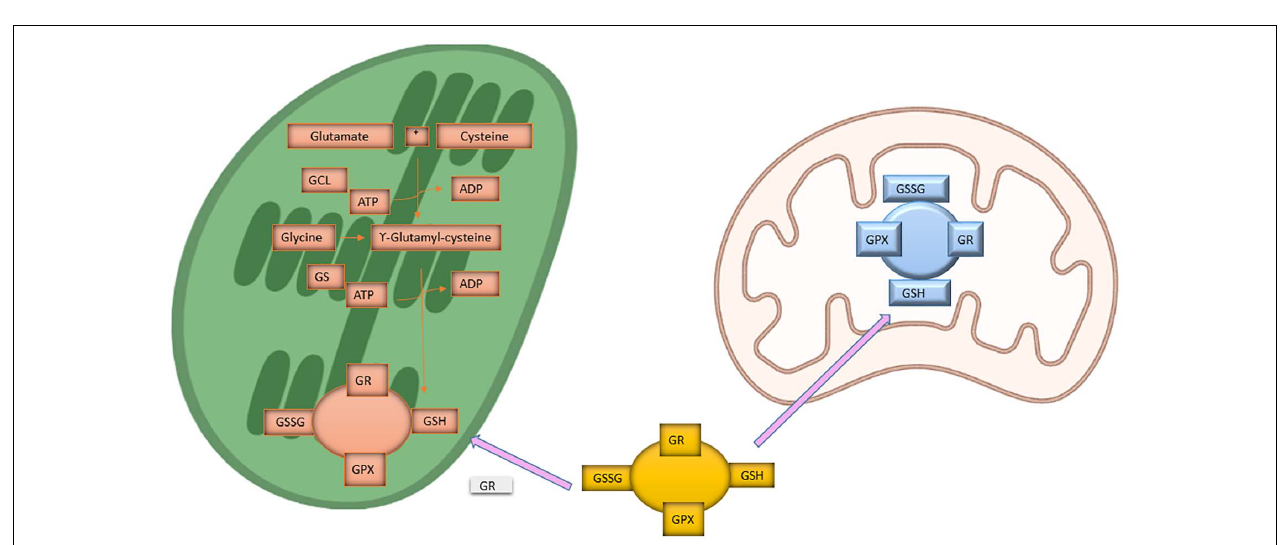
FIGURE 2 | Biosynthesis of Glutathione. The two ATP dependent steps involved in biosynthesis of Glutathione. Glutamate and cysteine leads to the formation of γ -glutamylcysteine and in the next step glutathione formation occurs by addition of glycine to γ -glutamylcysteine. This reduced glutathione (GSH) acts as substrate for numerous cellular reactions in cytosol and mitochondria to yield oxidized glutathione (GSSG).